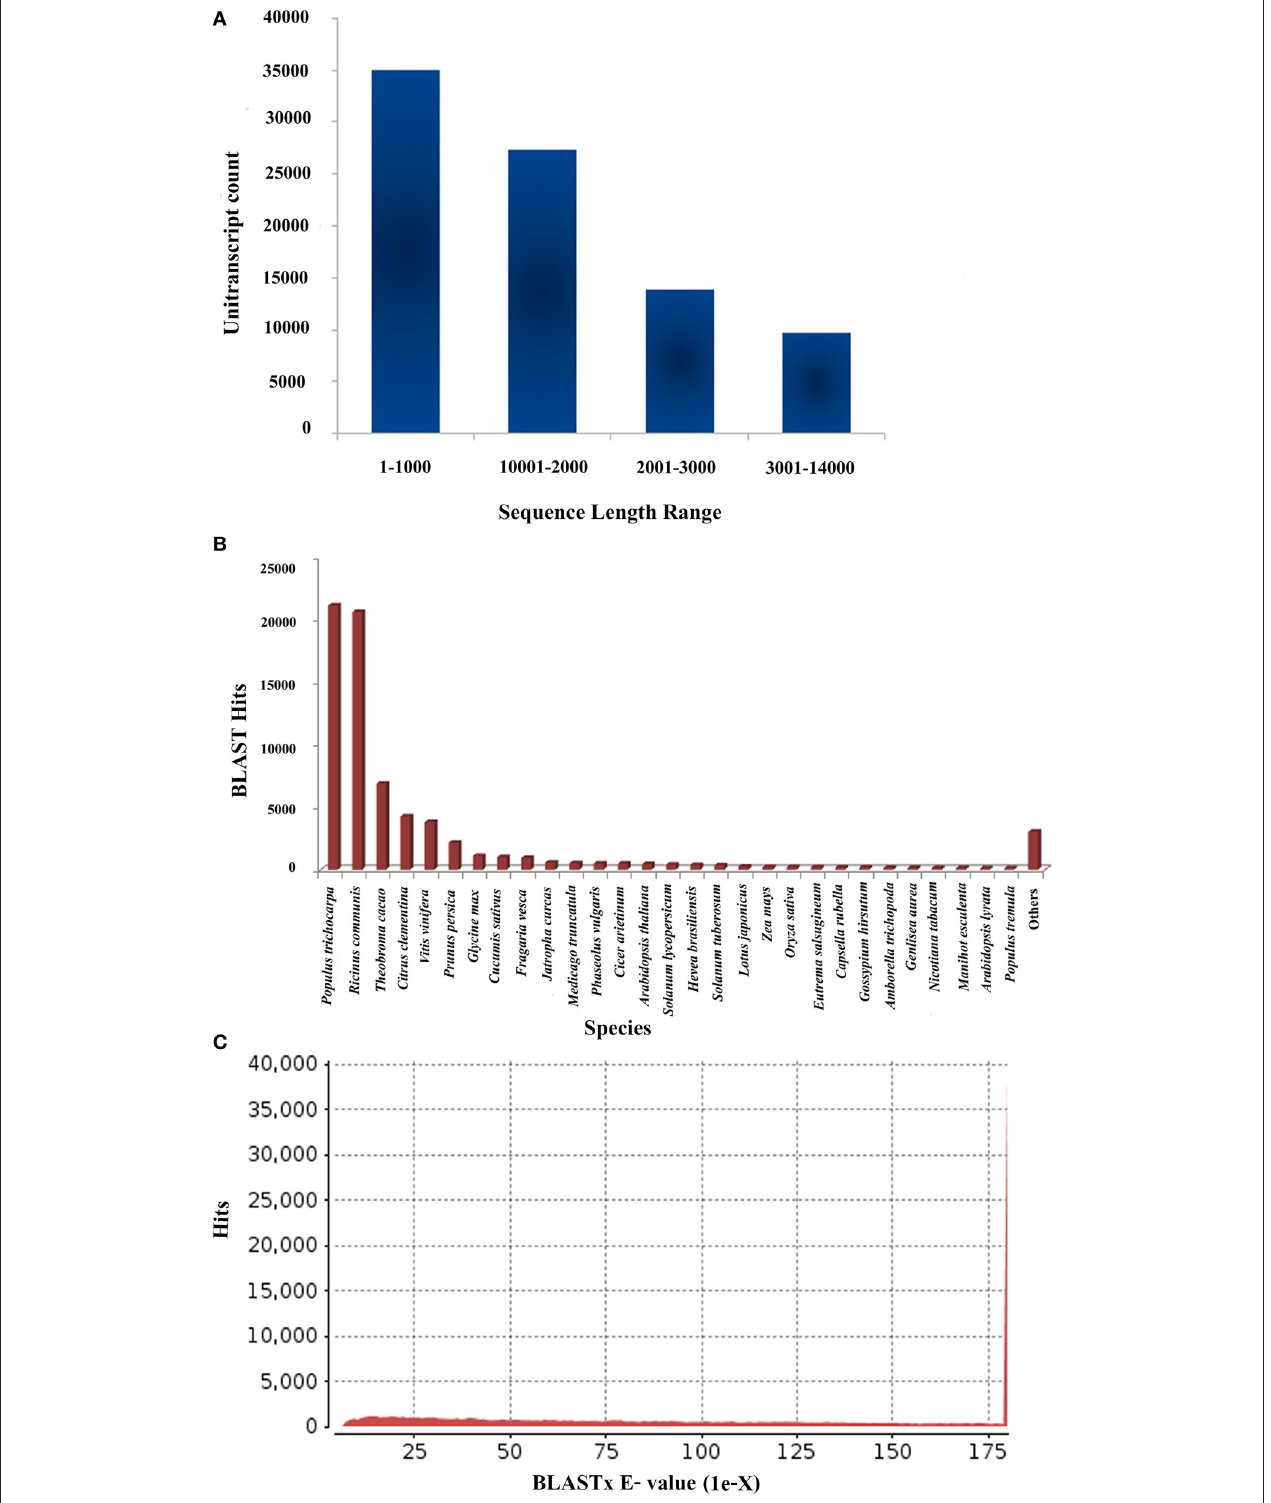
FIGURE 1 | Sequencing, de novo assembly, annotation of P. amarus leaf transcriptome. (A) Sequence length distribution of P. amarus non-redundant unique unitranscript sequences. (B) BLASTX-Hit species distribution of P. amarus unitranscripts against nr protein database. (C) E -value distribution of BLAST hits against nr protein